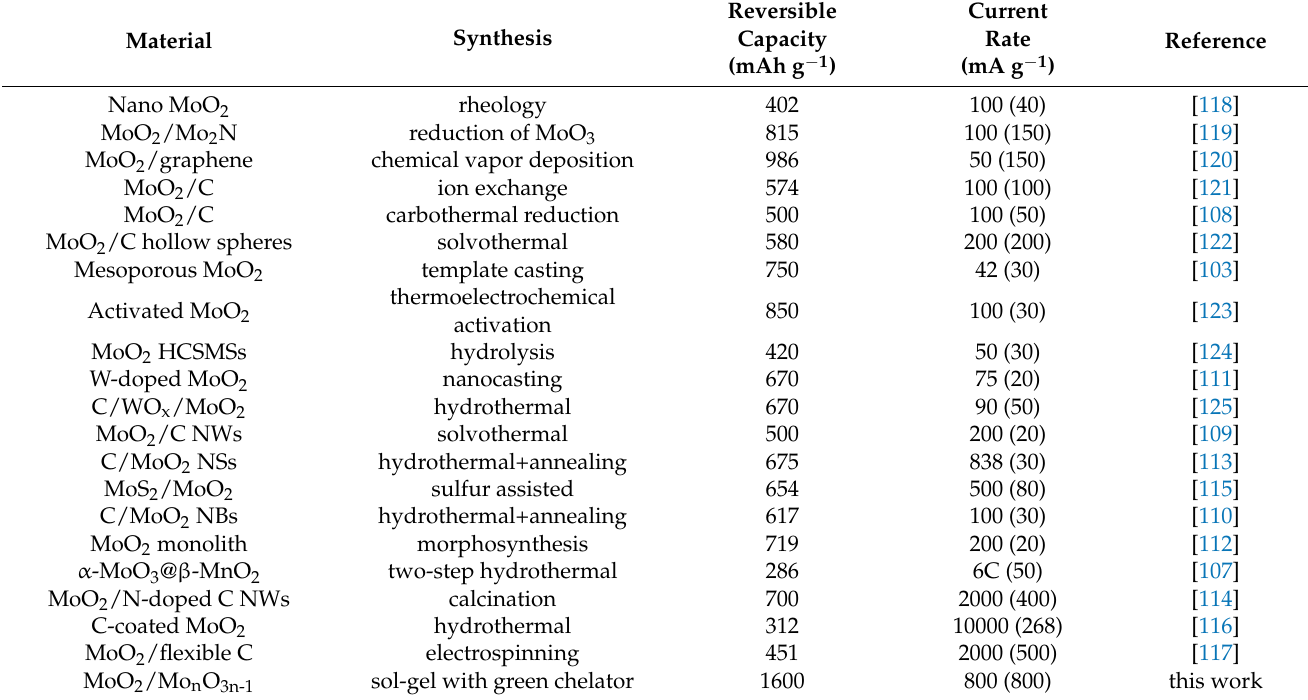
Table 5. Electrochemical performance of various MoO 2 composites as anode materials for LIBs. The cycle number at which the specific capacity is reported is given in